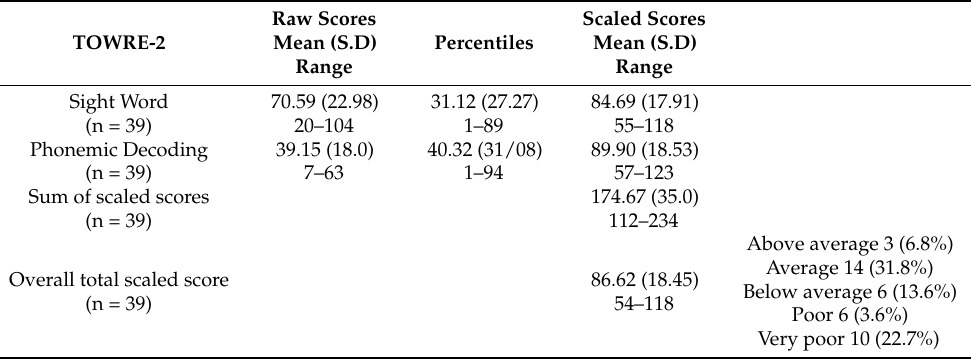
Table 2. TOWRE-2 single word reading mean scores, standard deviations, ranges and percentiles.